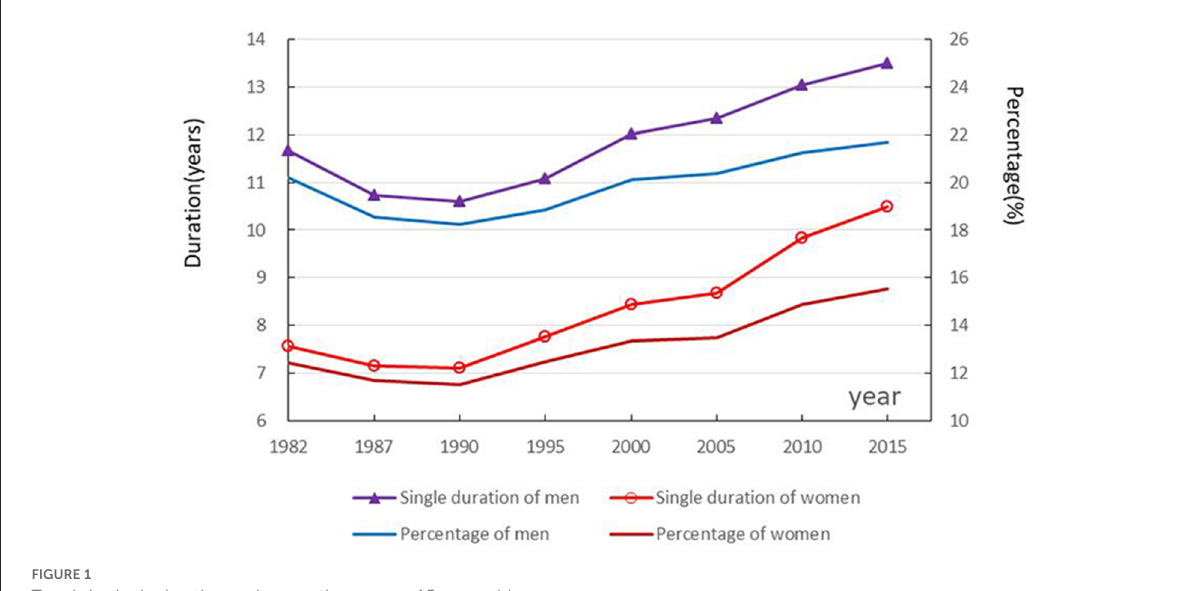
FIGURE1 Trends in single duration and proportion among 15-year-olds.